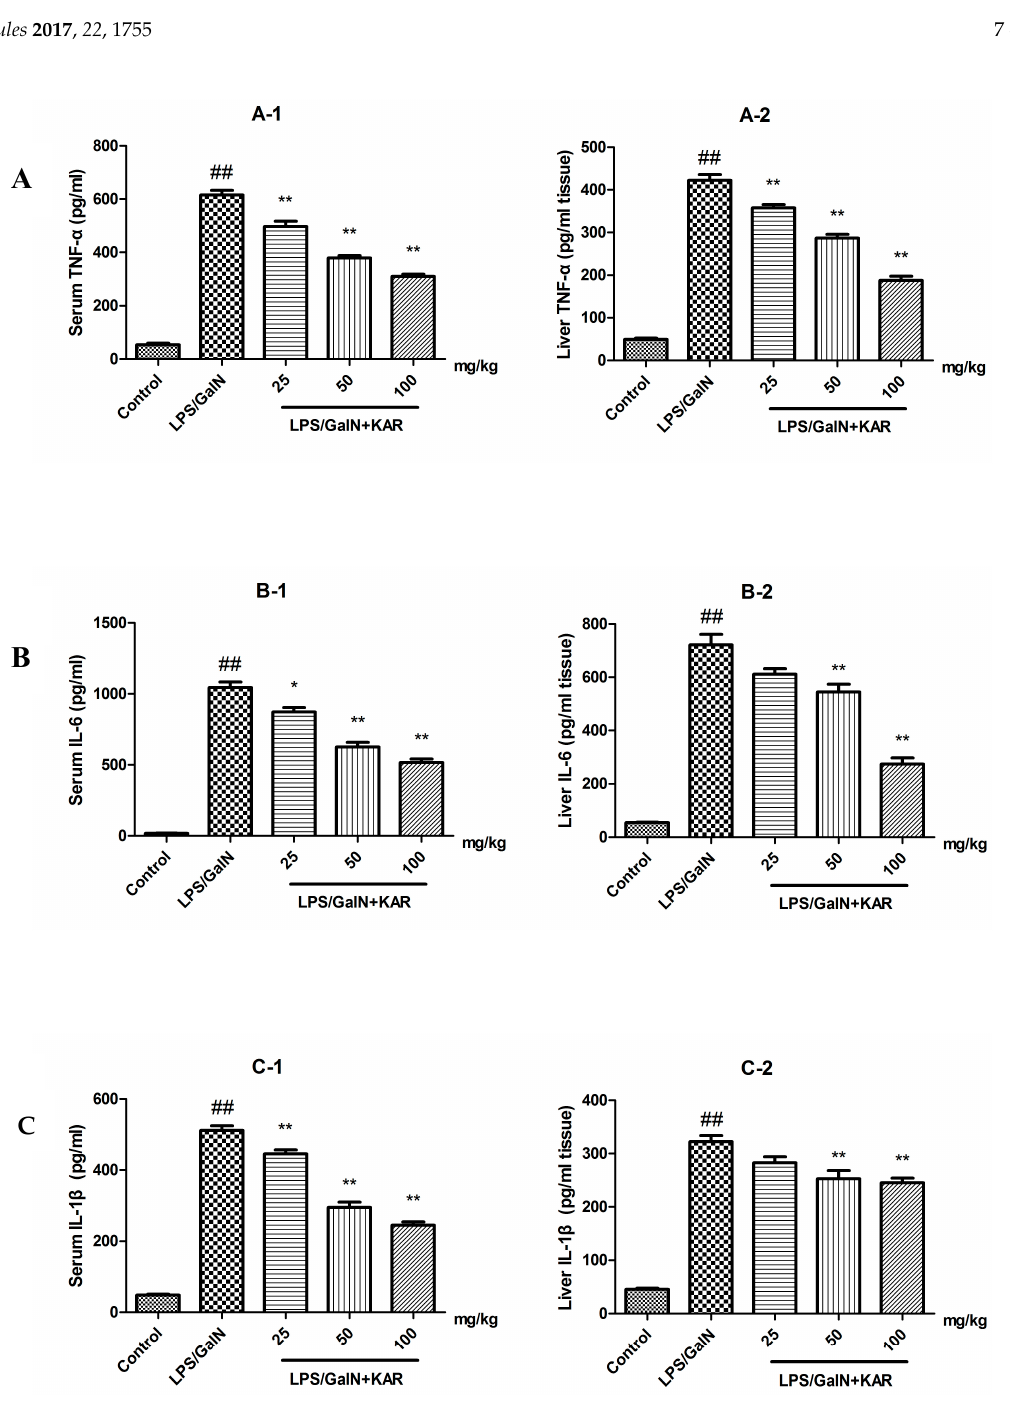
Figure 4. The production of TNF- α , IL-6, and IL-1 β ( A – C ) in serum and liver tissues were measured using an ELISA assay. The data represented show the mean ± SD ( n = 15). * p < 0.05, ** p < 0.01 compared to the FHF model group, and ## p < 0.01 compared to the control group.